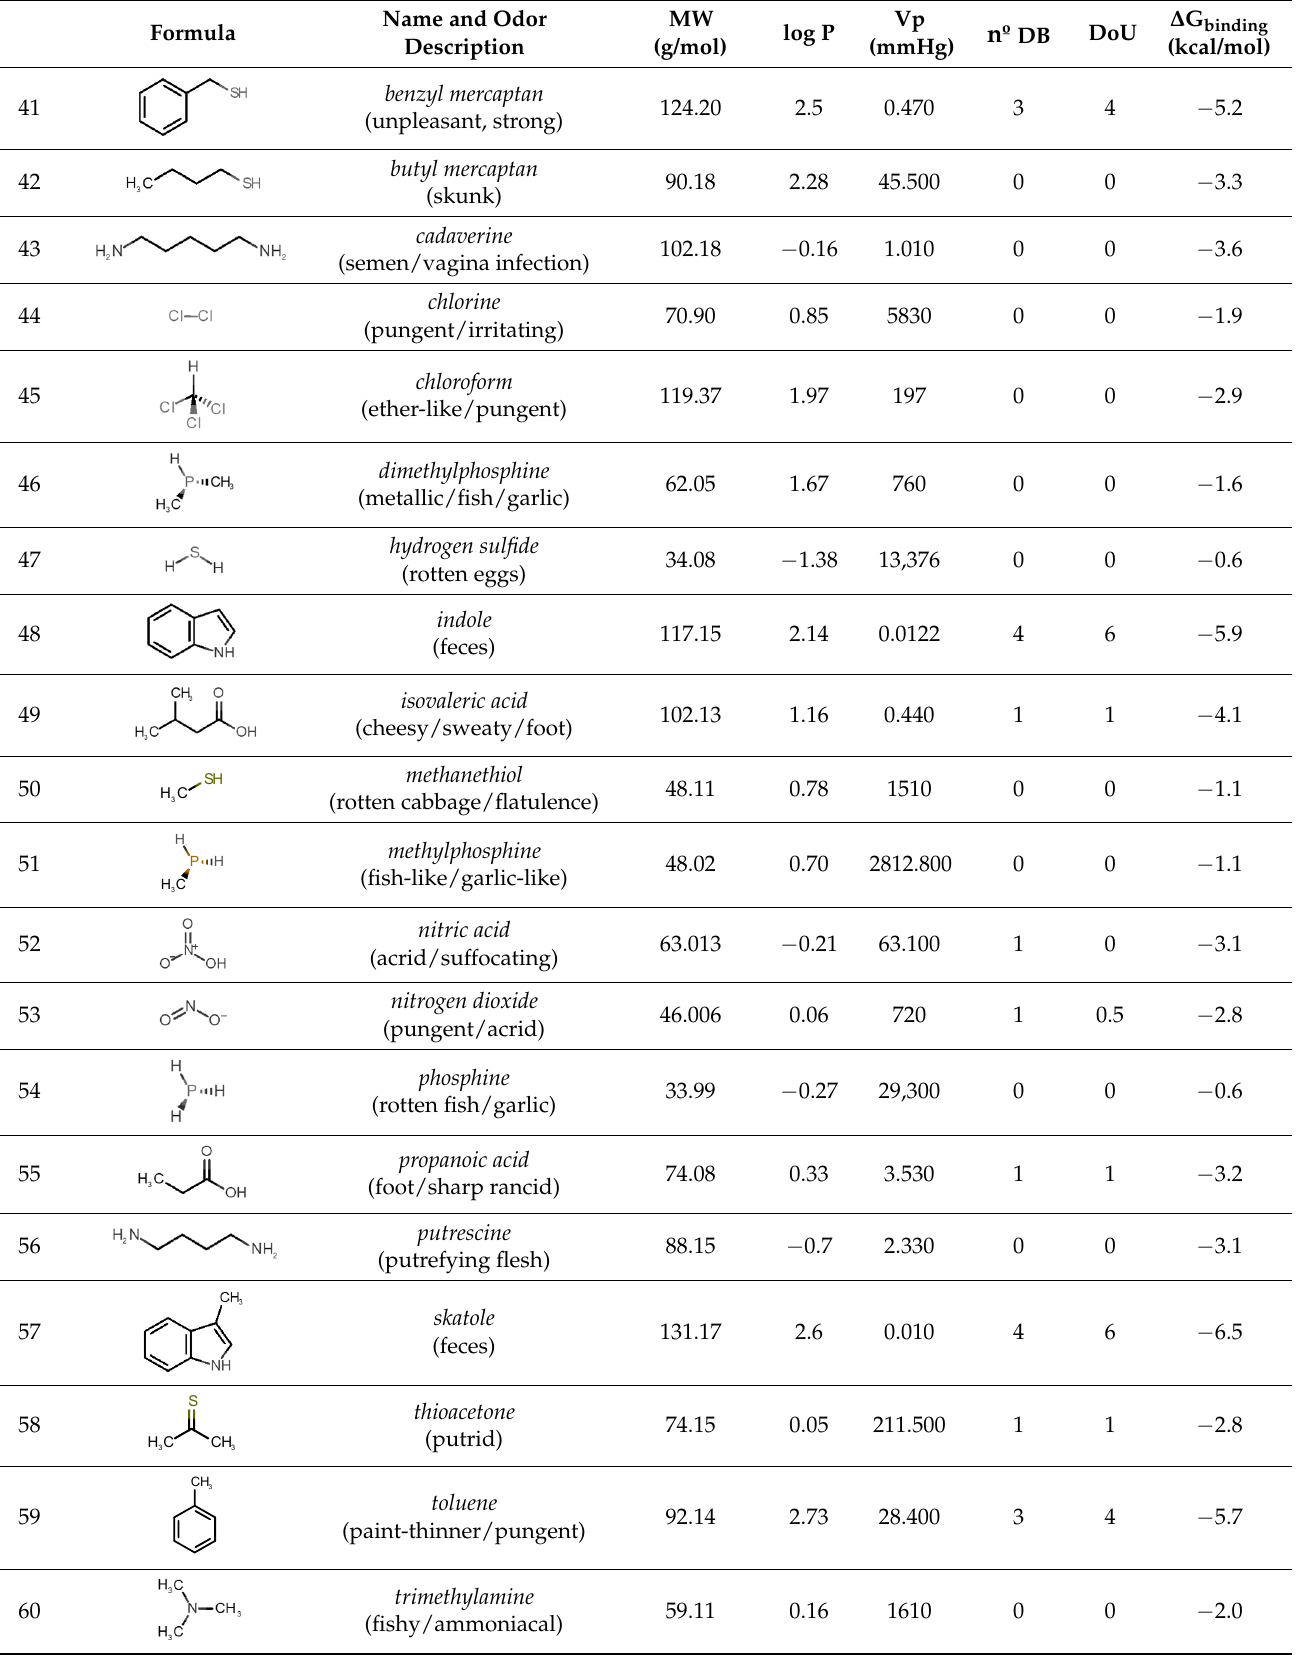
Table 2. Description of unpleasant odorant molecules under study, according to physicochemical and structural charac- teristics.